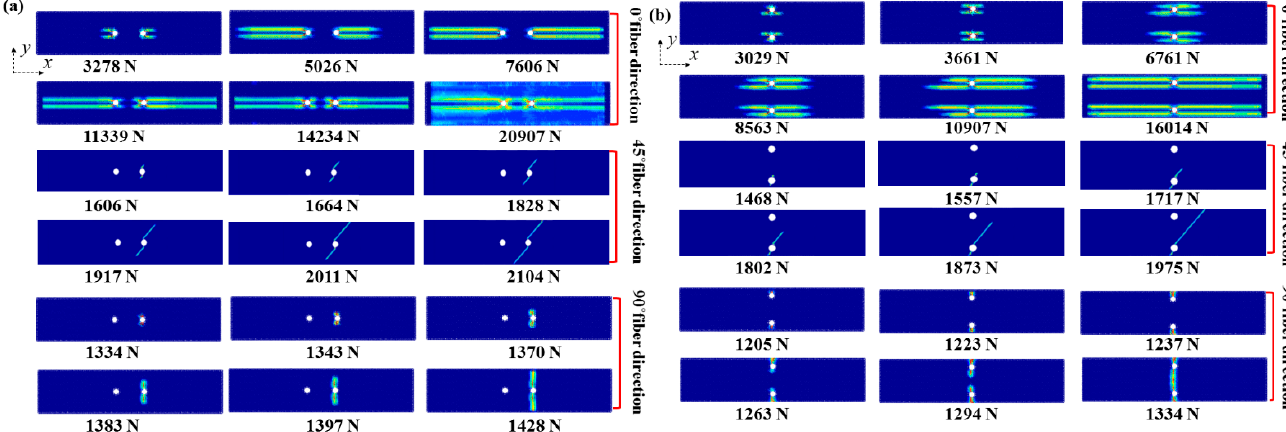
Figure 5. Observation of crack propagation in unidirectional composite plates for three different fiber directions with ( a ) two horizontal holes and ( b ) two vertical holes.